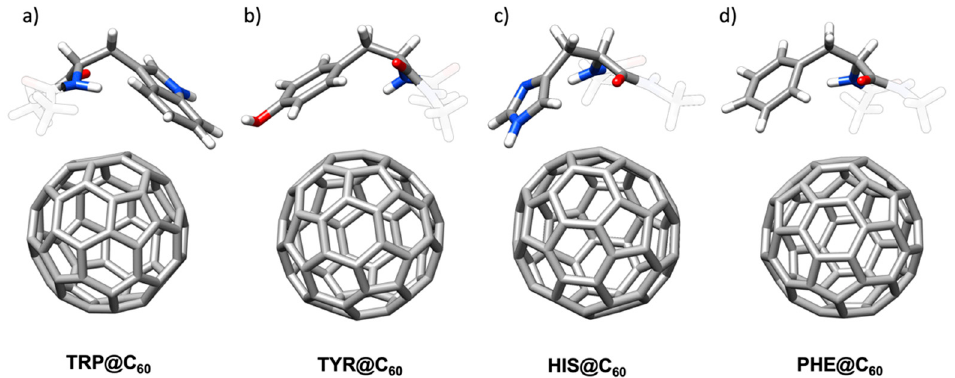
Figure 3. Snapshots from the MD of the interactions of aromatic amino acids ( a ) Trp, ( b ) Tyr, ( c ) His and ( d ) Phe with C 60 . For each amino acid, the most interactive configuration is shown.